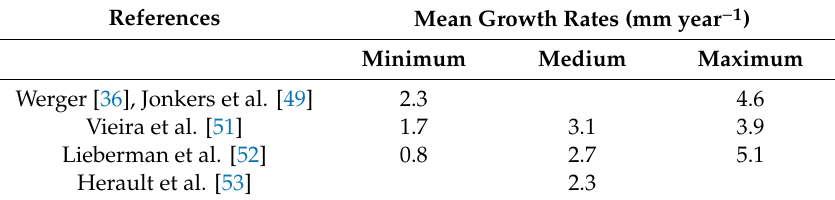
Table 4. Mean growth rate